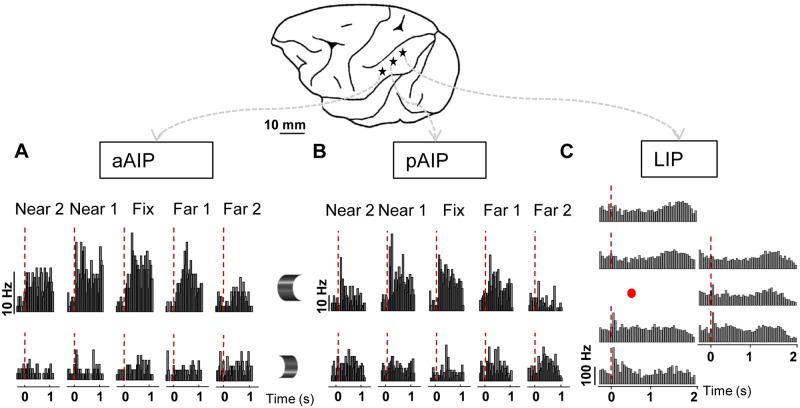
Functional properties of IPS subsectors.A. aAIP. Example neuron showing selectivity for disparity-defined depth-structure (convex versus concave; rows), across different positions in depth (columns). B. Example neuron in pAIP showing selectivity for disparity-defined depth-structure (convex versus concave), across different positions in depth (columns). C. LIP. Example neuron with target-selective responses in a visually guided saccade task. Histograms demonstrate the seven possible target locations, positioned as shown on the screen. The position of the central fixation point is marked with the red dot.